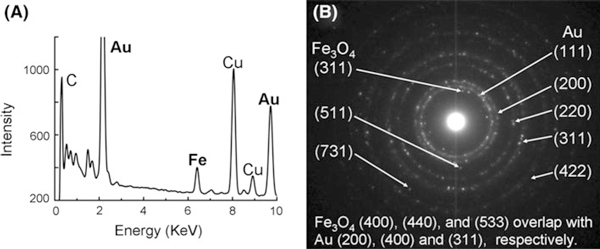
a EDS spectrum of one single particle, showing the coexistence of Au and Fe. b SAED pattern from three particles, showing a superposition of Au and Fe3O4 lattices.